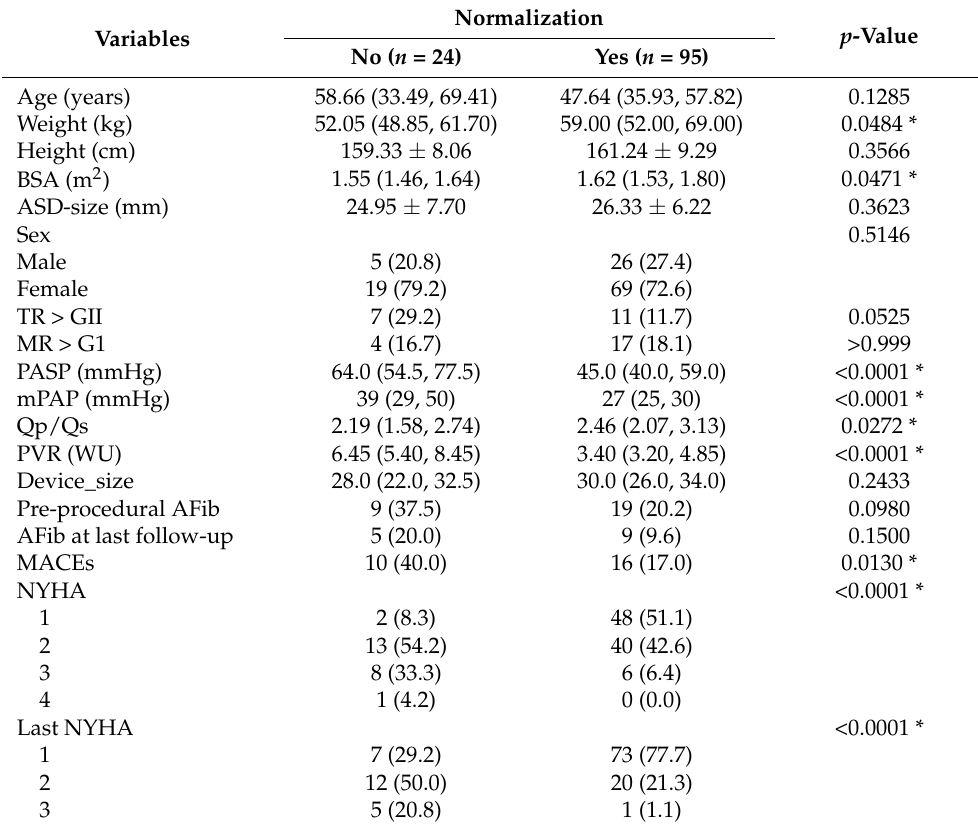
AFib, atrial fibrillation; ASD, atrial septal defect; BSA, body surface area; MR, mitral regurgitation; NYHA, New York Heart Association functional class; MACEs, major adverse cardiovascular events; mPAP, mean pulmonary arterial systolic pressure; PASP, pulmonary arterial systolic pressure; PVR, pulmonary vascular resistance; Qp, pulmonary flow; Qs, systemic flow; TR, tricuspid regurgitation; RVSP, right ventricular systolic pressure; tcASD, transcatheter closure of atrial septal defect. * p -value < 0.05 was considered to be statistically